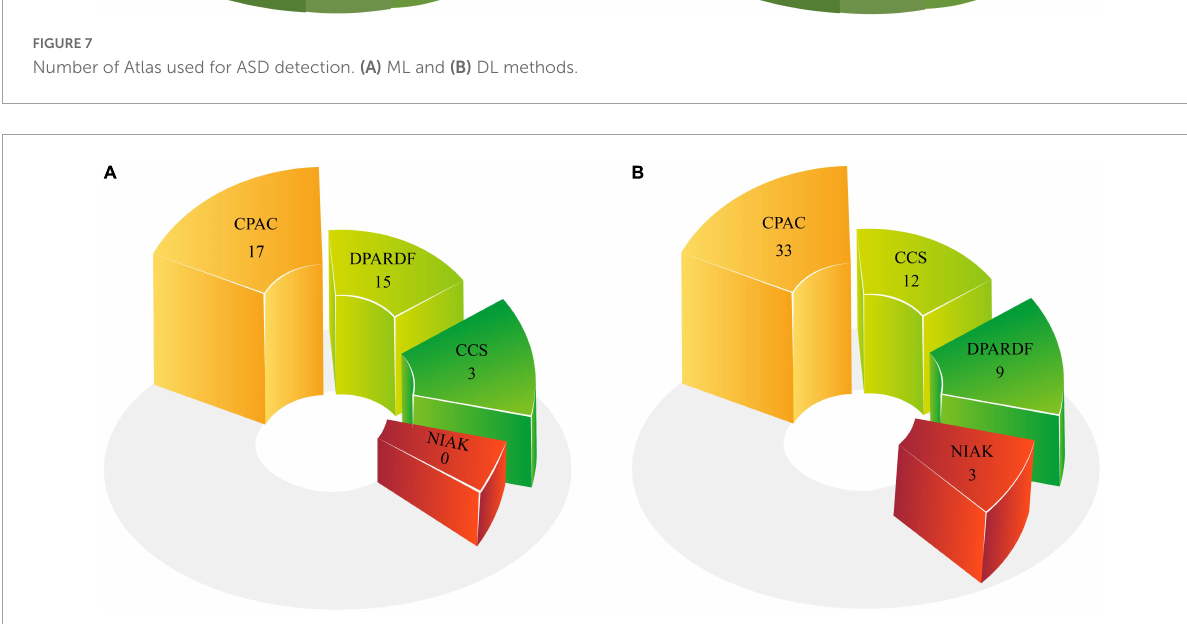
FIGURE8 Number of pipelines used for ASD Detection: (A) ML and (B) DL